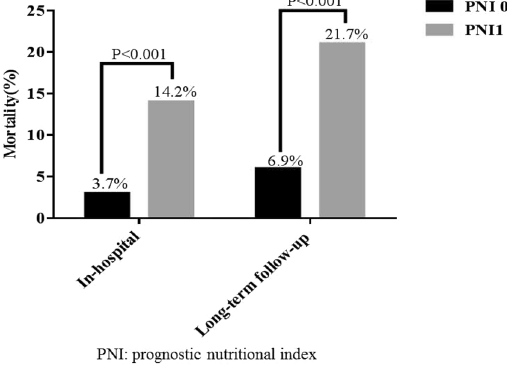
Figure 1. In-hospital and long-term follow-up mortality in the PNI = 0 and PNI = 1 groups of STEMI patients who underwent